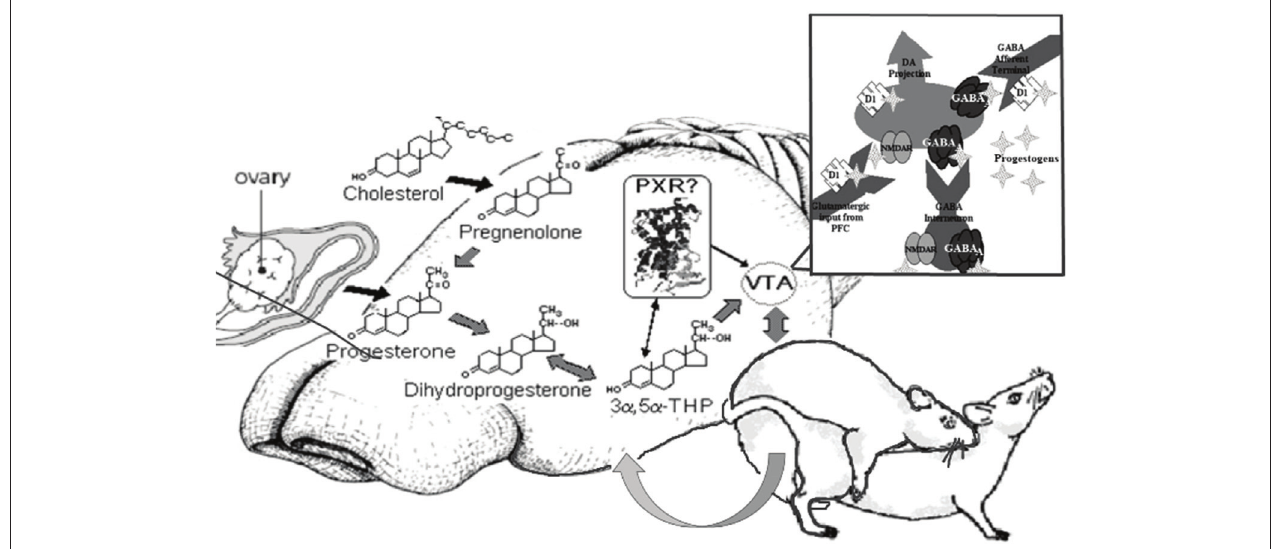
to date suggest that PXR is a novel target of allopregnanolone in the midbrain VTA, as are neurotransmitter targets (e.g., GABA, NMDA), for functional, reproductively-relevant responses, as well as biosynthesis of allopregnanolone in the brain (i.e., acting upstream of